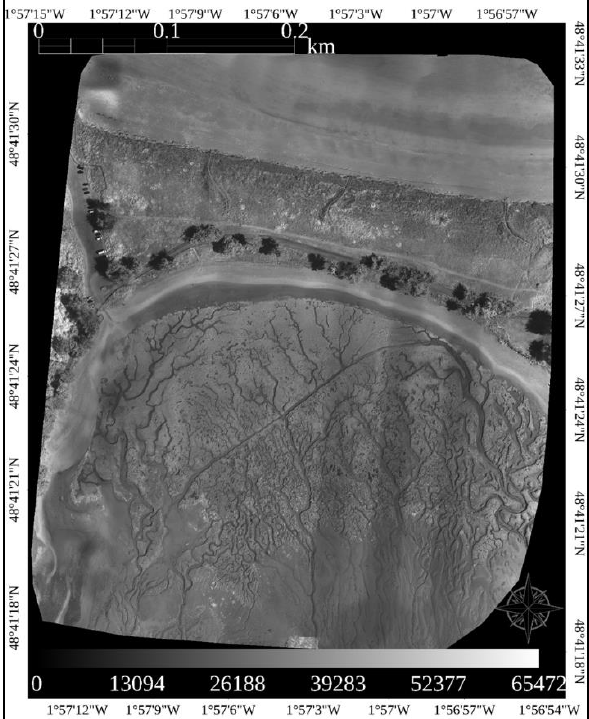
Figure 2 . Infrared orthomosaic (7132 × 8974 pixels) derived from the Sequoia+ sensor, based on 310 reflectance